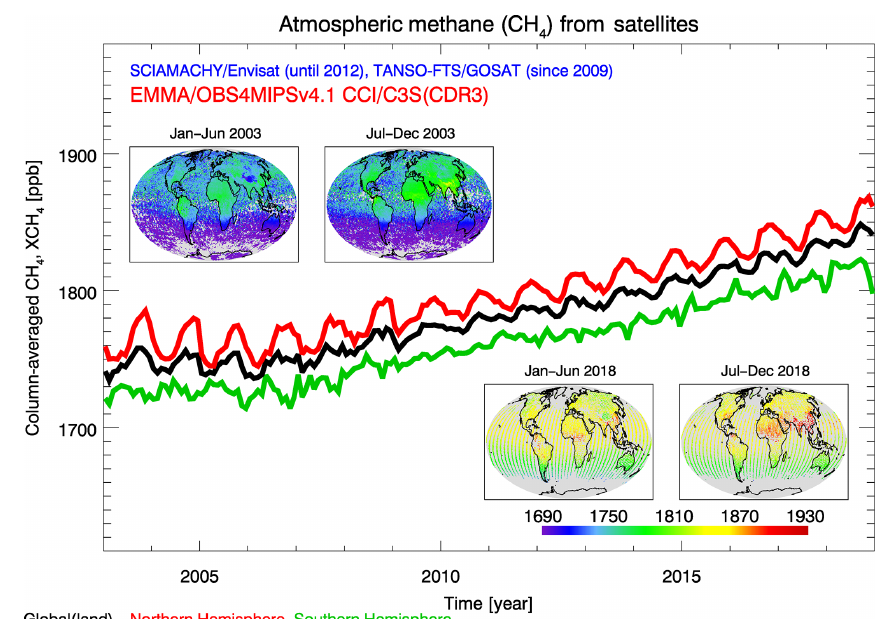
Figure 2. As Fig. 1 but for XCH 4